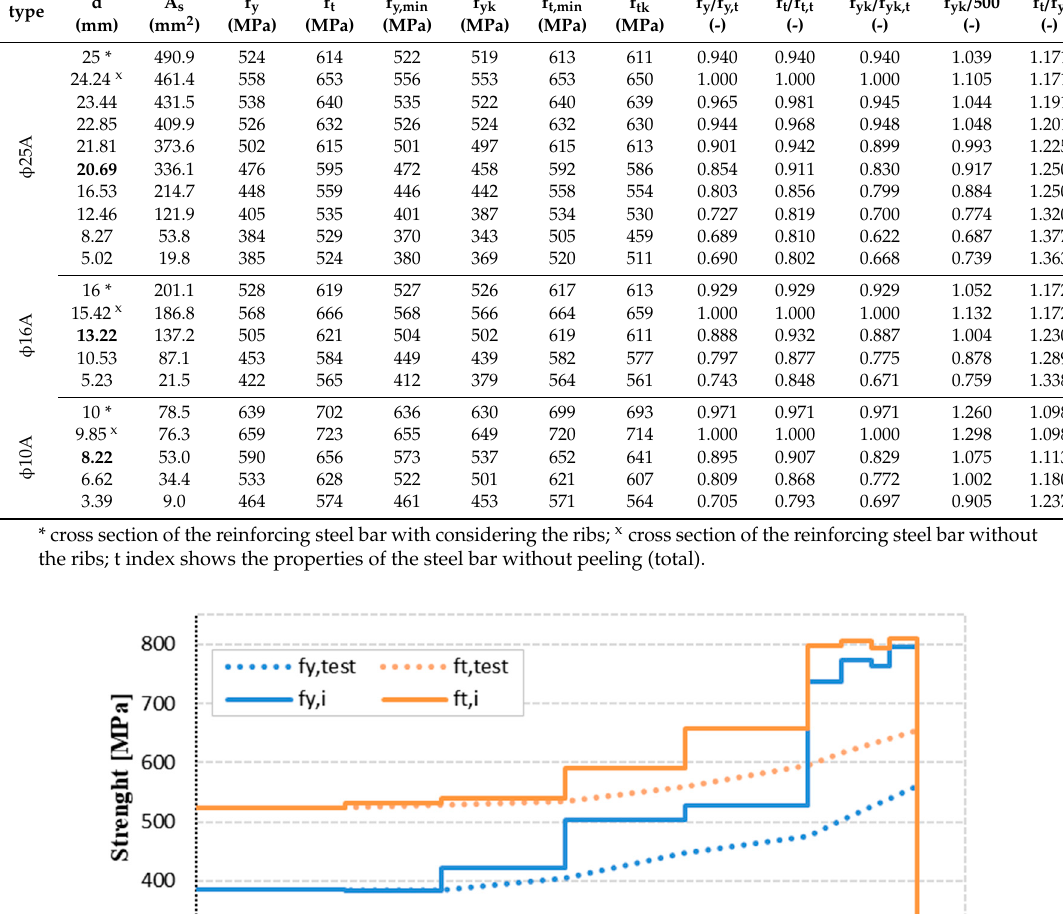
1.237 * cross section of the reinforcing steel bar with considering the ribs; x cross section of the reinforcing steel bar without the ribs; t index shows the properties of the steel bar without peeling (total). Figure 6 shows the measured values of YS and TS of the samples with basic diameter 25 mm ( φ 25, producer A) depending on the modified diameter shape. The measured value of YS and TS has higher scatter in the core. The lowest values of YS and TS were observed at the core and the higher value at the surface layer. The bold numbers in Table 2 indicate the diameters of the core areas of threads M10, M16, and M24. The measurements show that with all the three diameters the TS at these diameters is higher than 550 MPa (value governing the tensile strength of the bolt in accordance with Equation (1)). The YS is lower than 500 MPa only in specimen φ 25 A, Figure 7. Figure 8 illustrates the strain-hardening potential, the ratio of TS to YS (f t /f y ). The ratio ranges between 1.1 (r/r t = 1.0) and 1.23 (r/r t = 0.35) for bars with diameter of 10 mm. The strain hardening for bars with diameter of 16 mm ranges from 1.17 (r/r t = 1.0) to 1.34 (r/r t = 0.34) and for bars with a diameter of 25 mm it ranges between 1.17 (r/r t = 1.0) and 1.36 (r/r t = 0.21). It is observed that strain hardening starts to increase in the modified shape of the rebar by peeling (high strain-hardening